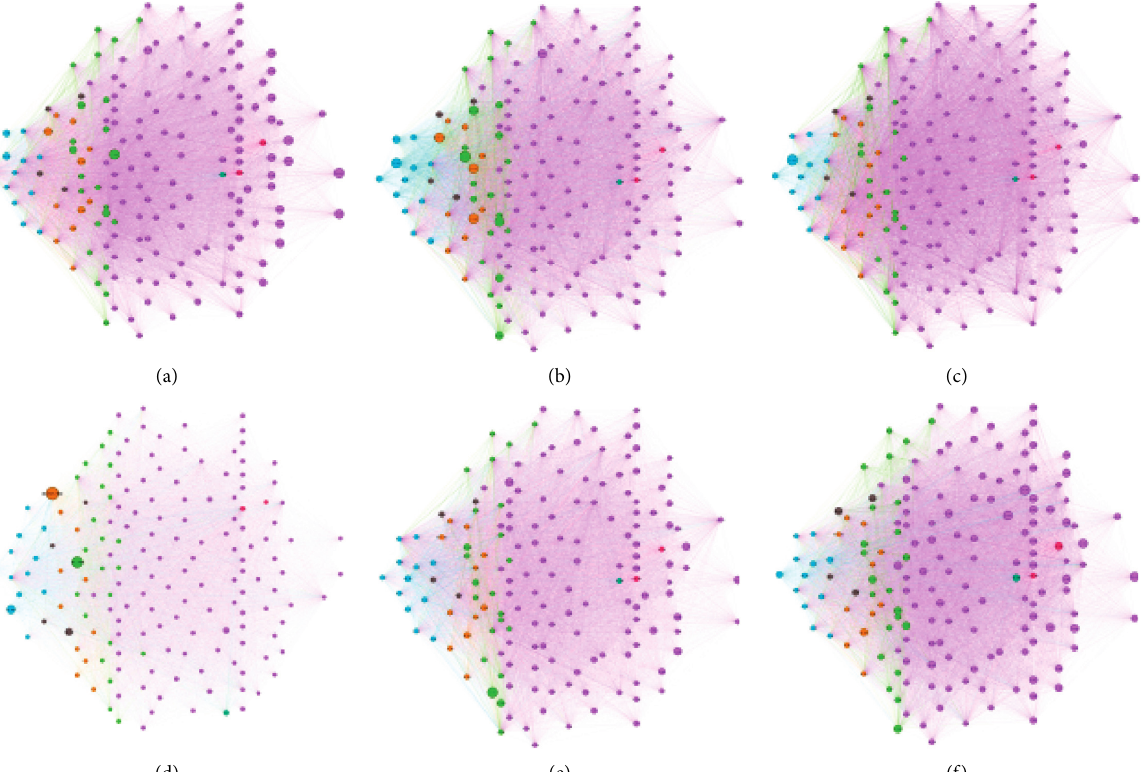
Figure 16: GHSOM cluster comparison. (a) Mark Rothko’s Primeval Landscape of 1945. (b) Level 1 SOM of IR to the first dataset of 161 paintings. Cluster of 34 elements. The second row corresponds to the second dataset of 91paintings. Cluster of 14 elements. (c) Level 2 of SOM of the respective datasets. Cluster of 13 and 4 elements,